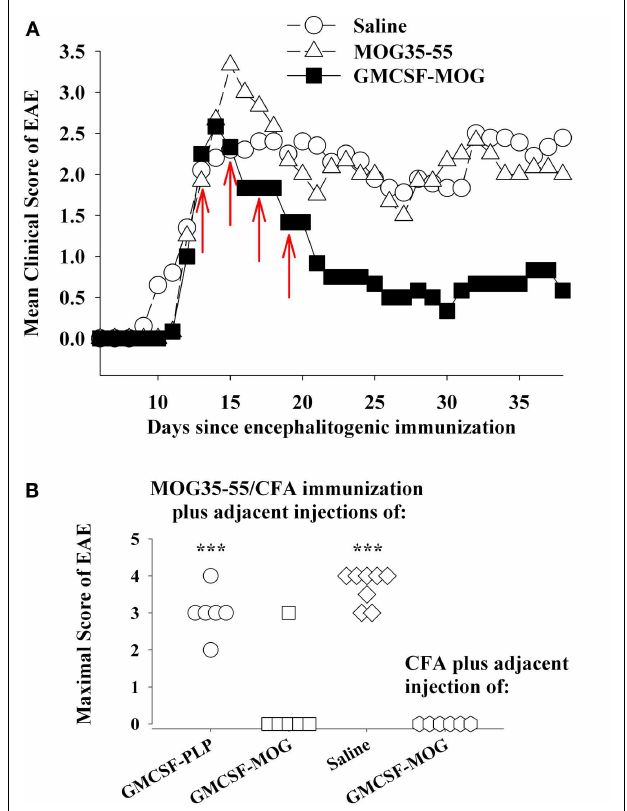
FIGURE 6 | GMCSF-MOG was an effective therapeutic in pro-inflammatory environments. (A) Mice were immunized on day 0 with 200 µ g MOG35–55 in CFA and were also given Pertussis toxin (200ng i.p.) on days 0 and 2.When the majority of mice began showing paralytic EAE, mice were matched for clinical signs of EAE and were injected with the synthetic peptide MOG35–55, GMCSF-MOG (2nmol subcutaneously in saline), or saline on days 12, 14, 16, and 18 (red arrows). Mean maximal disease scores of mice treated with GMCSF-MOG significantly differed from those treated with saline ( p = 0.015; non-parametric ANOVA based on ranked scores). (B) On day 0, mice were given an injection of MOG35–55 in CFA to elicit EAE along with an adjacent injection ( ∼ 1mm apart) of 2nmol GMCSF-PLP, GMCSF-MOG (in saline), or saline. A separate group of mice were injected with a saline/CFA emulsion and an adjacent injection of 2nmol GMCSF-MOG. All four groups also received Pertussis toxin (200ng i.p.) on days 0 and 2. Maximal EAE scores of mice given adjacent injections of “MOG35–55/CFA and GMCSF-MOG (second column)” or “saline/CFA and GMCSF-MOG (fourth column)” differed from those for mice injected with MOG35–55/CFA and either GMCSF-PLP (first column) or saline (third column; p ≤